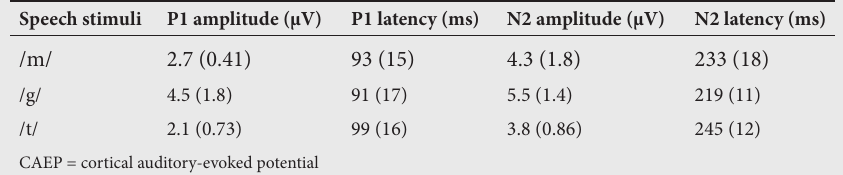
Table 2. Mean peak amplitudes, latencies and standard deviations for P1 and N2 components of the CAEP for younger group aged 5 - 7 years, in response to the three speech sounds /m/, /g/, /t/